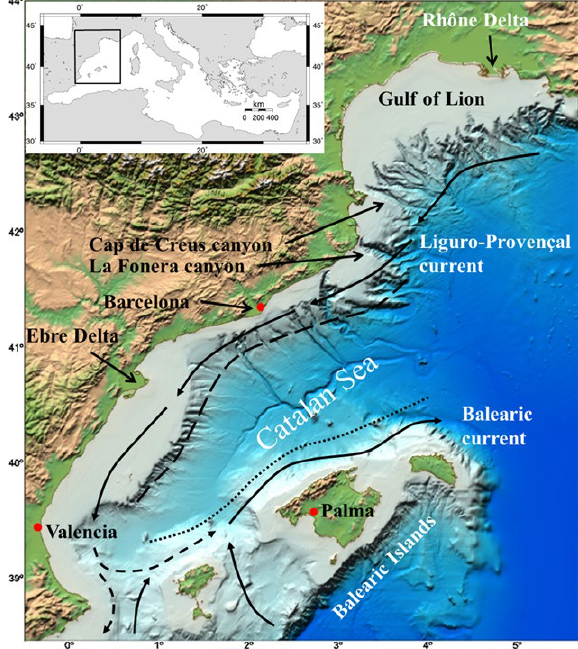
Fig. 1. – Bathymetric map of the Catalan Sea (2005 Catalan-Balearic Sea. Bathymetric Chart and Toponyms, www.icm.csic.es/geo/gma/ MCB/MCBexplora_cat.htm). The pathway of the Liguro-Provençal (or Northern) and Balearic Currents is shown (arrows), as well as an approximate position of the Catalan and Balearic fronts (dashed and dotted lines, respectively), as in Pascual et al. (2002). The inlet map shows the location of the Catalan Sea in the Mediterranean Sea (created using